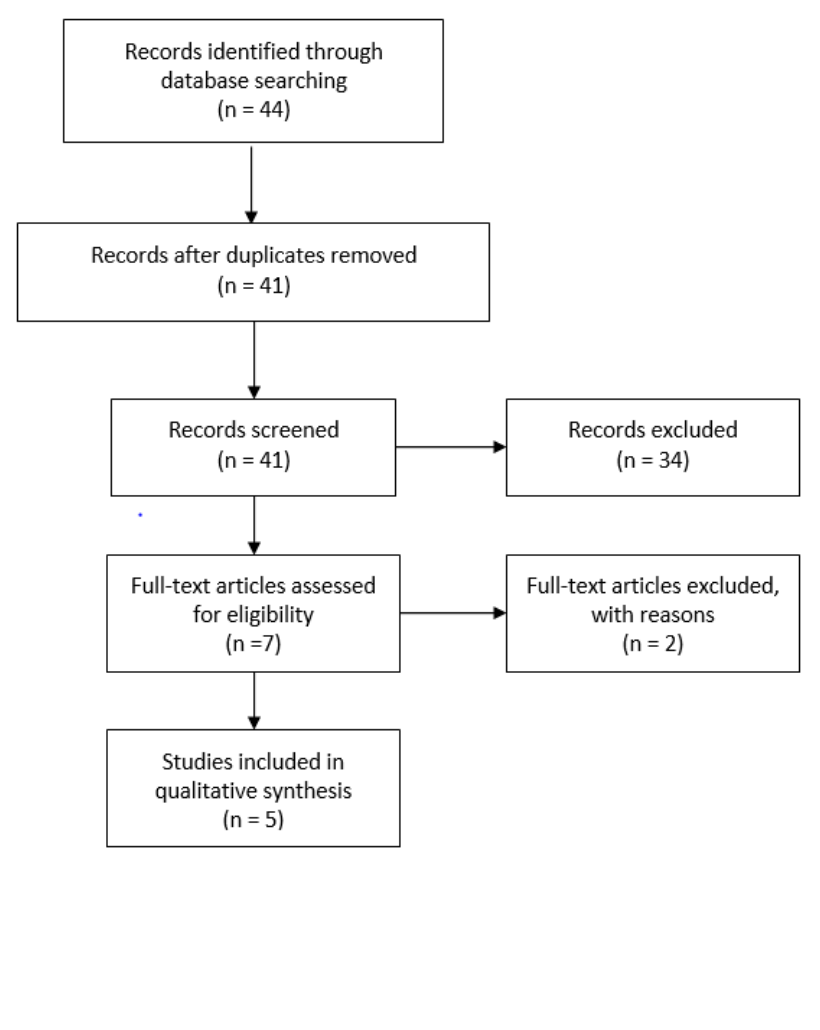
Figure 1. Prisma flow diagram.